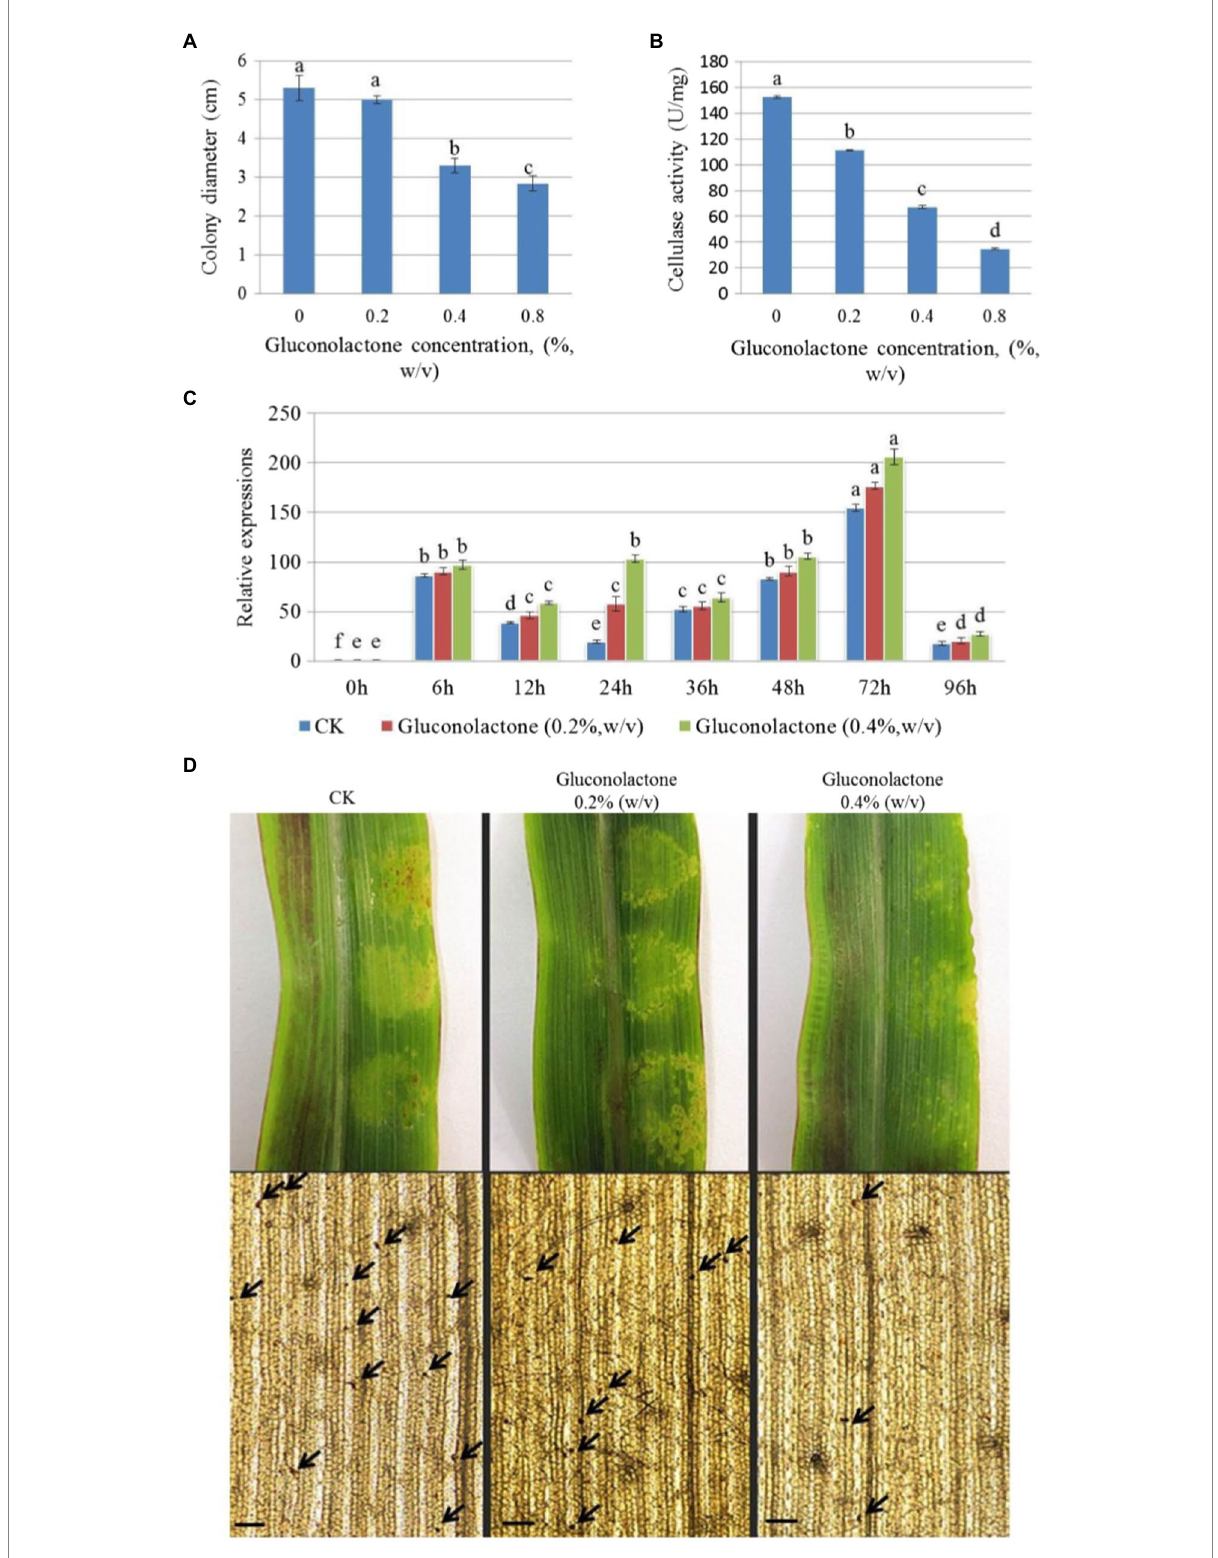
FIGURE 5 Effect of gluconolactone on Setosphaeria turcica f. sp. zeae . (A) Effect of gluconolactone on colony diameter. Error bars are presented as means ± SE ( n = 5). Different letters indicate significant differences ( p < 0.05). (B) Effect of gluconolactone on cellulase activity. Error bars indicate means ± SE ( n = 3). (C) Effect of glucolactone on the expression level of endo-1, 4- β -D-glucanase encoding gene StCEL2 . Data represent means ± SE ( n = 3). (D) Effect of gluconolactone on the pathogenicity and infection rate. Arrow positions are the infection dots. Scale bars are equal to 50 μ